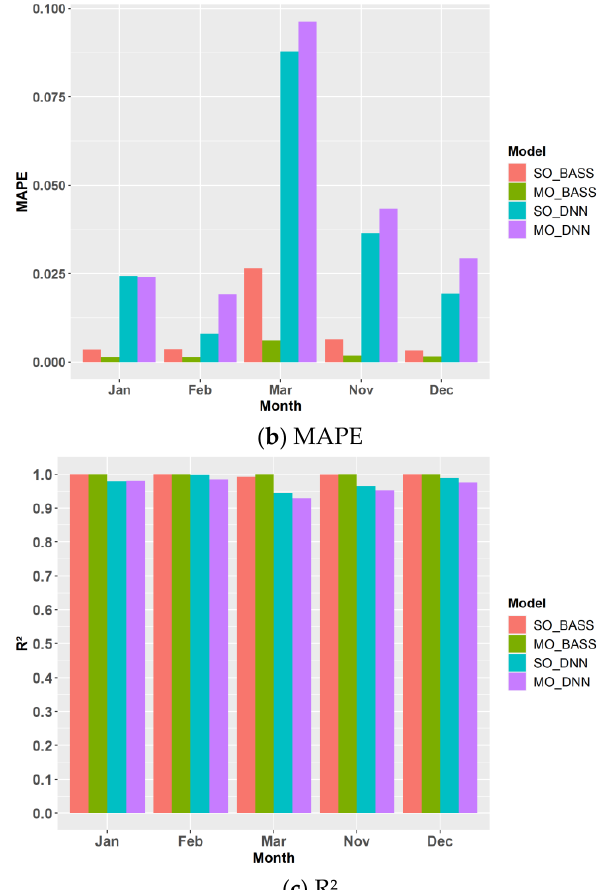
Figure 16. Prediction performance of four machine learning models for monthly heating energy. The modeling time of the four monthly heating energy models is listed in Table 5.